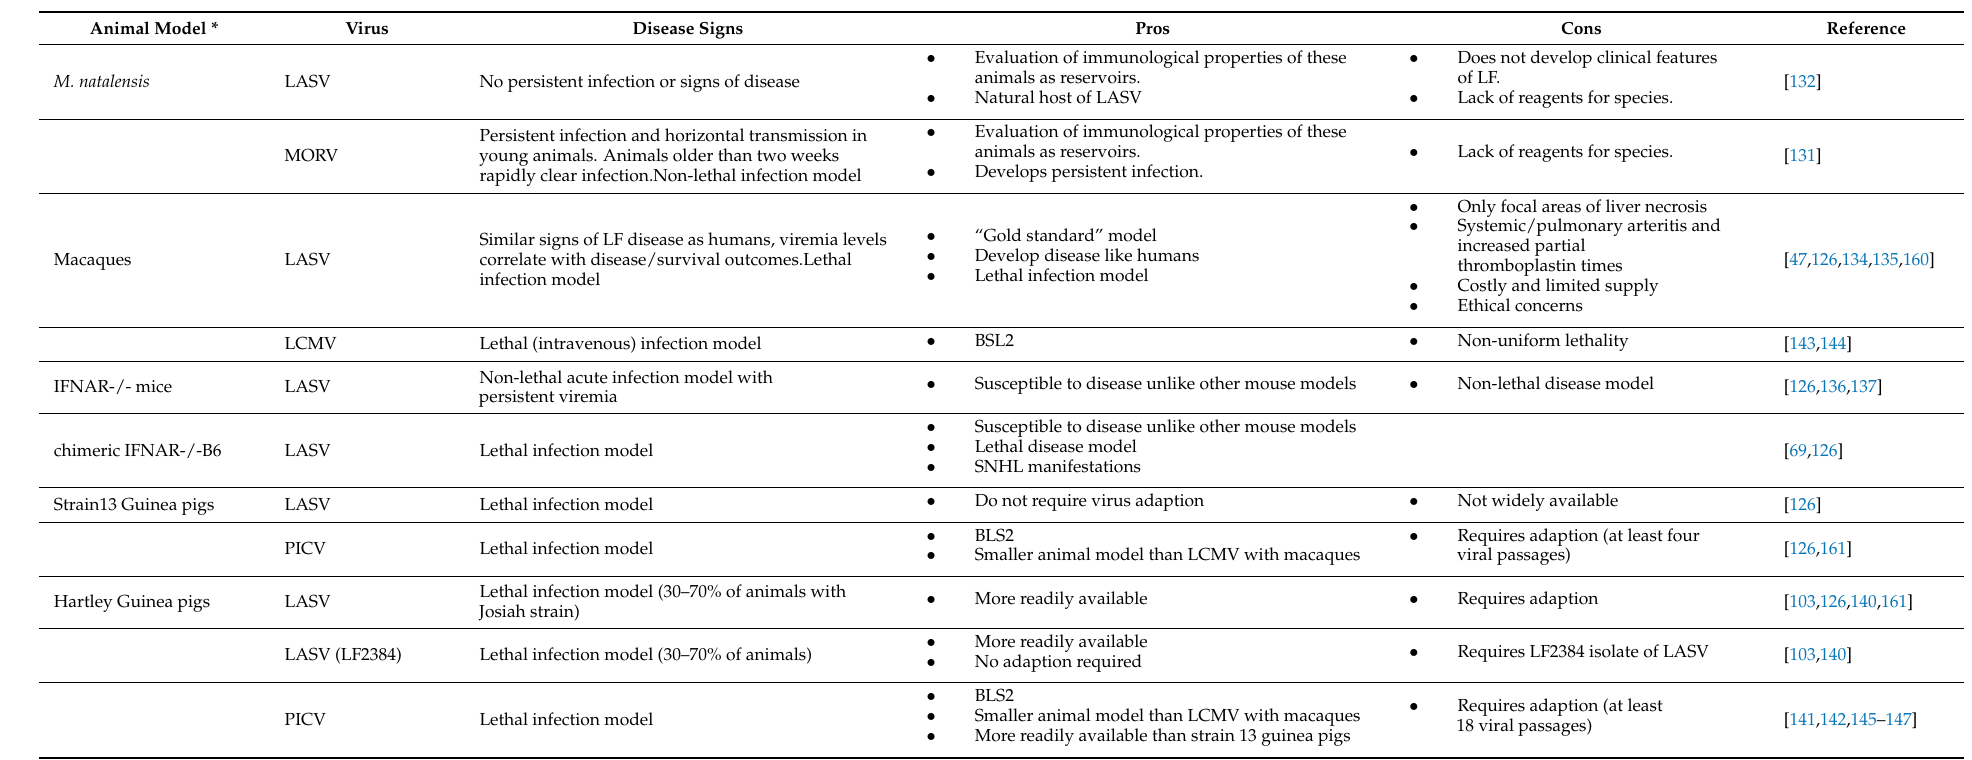
Table 2. Summary of LASV animal